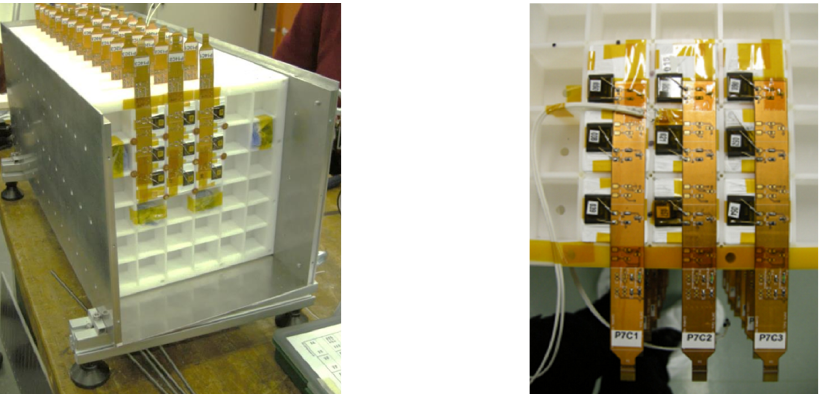
Figure 3. Left panel : The first calorimeter prototype under construction; Right panel : Details of a single layer, showing the nine large area photodiodes placed on the crystals, wrapped in white teflon tape, and the kapton cables used to read out the